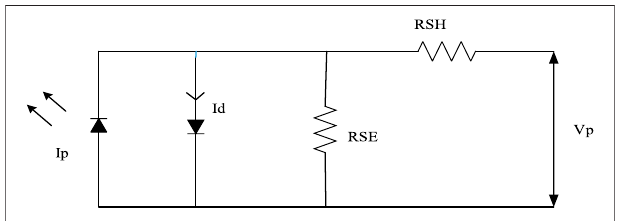
FIGURE 4 | Schematic diagram of PV.